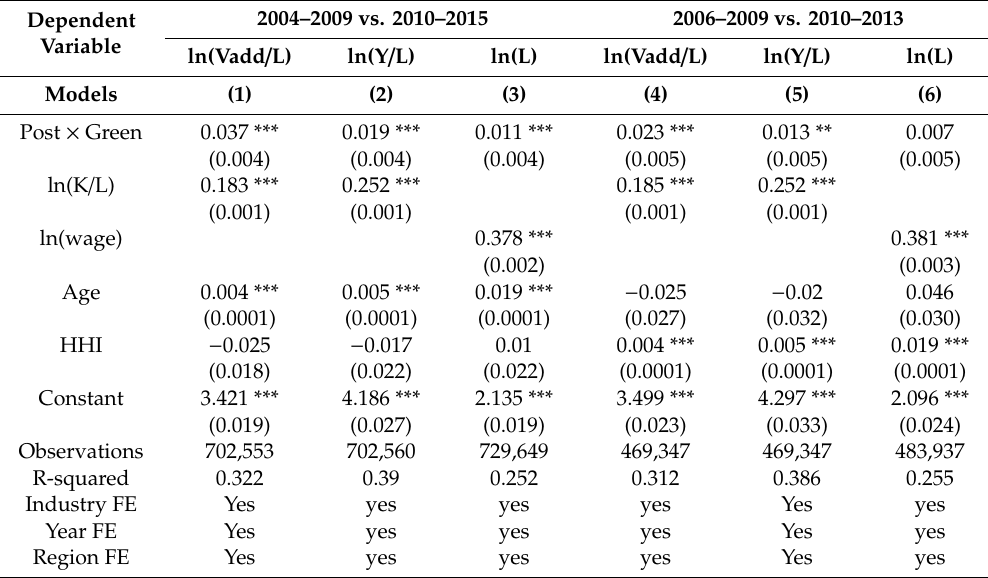
Table 3. Estimation results based on labor productivity and employment as dependent variables for the green sector.